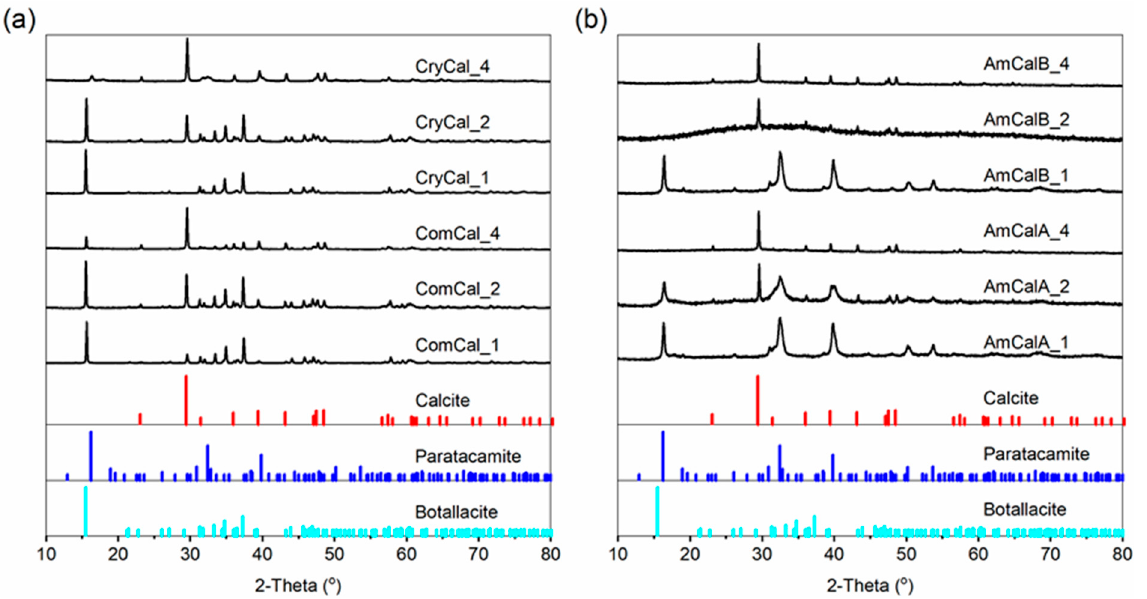
Figure 4. Powder XRD patterns of the products after Cu 2+ removal with different material dosage. ( a ) CryCal and ComCal, ( b ) AmCalA and AmCalB.